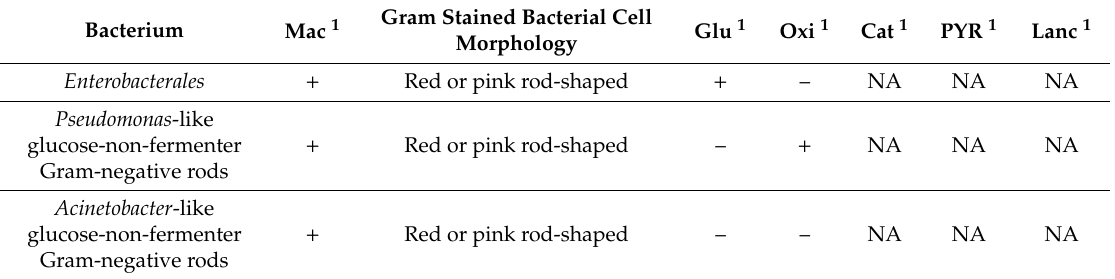
Table 2. Basic biochemical identification of common